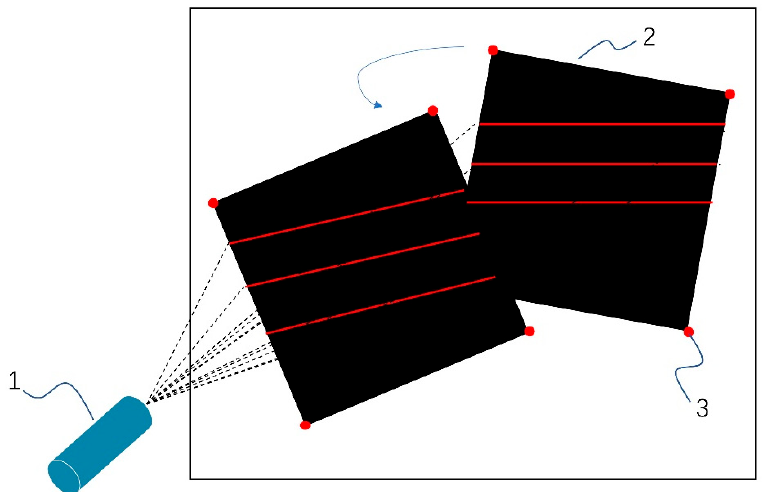
Figure 6. Three-line light plane calibration. (1) Three-line laser, (2) A flat target with black square pattern, (3) Corner Point.